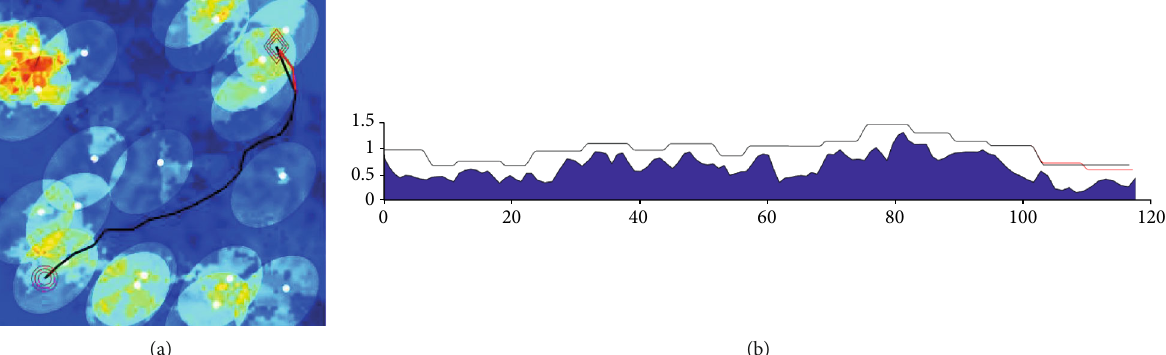
Figure 12: Original path (black line) and a modi fi ed path by waypoint insertion (red line): (a) horizontal path; (b) the altitude according to the travelled distance in the horizontal plane.